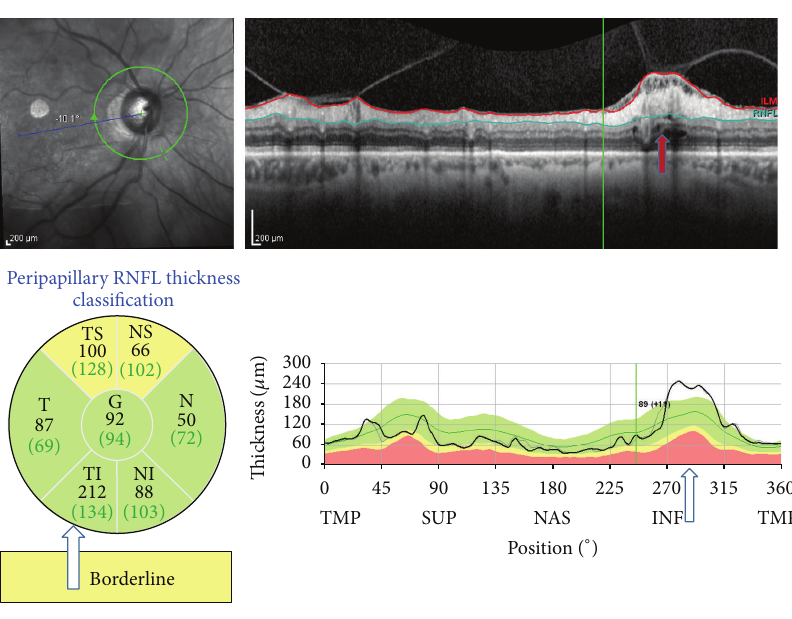
Figure 3: SD-OCT findings in a case of primary open angle glaucoma. The retinoschisis observed with vitreopapillary traction in the B- scan image (red arrows). The remarkable increase in the RNFL thickness in the inferotemporal area is also seen in the TSNIT graphs (white